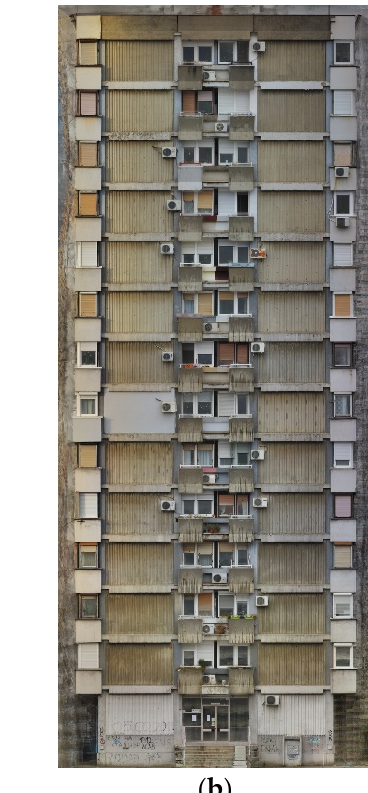
Figure 4. Southeast building façade: generated ( a ) point cloud with over 35 million points and ( b ) orthofaçade with an average GSD of 2.2 mm.